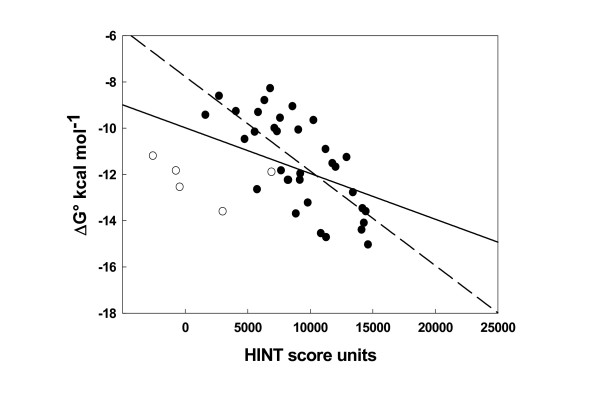
Correlation between the experimental binding free energies and the calculated HINT score values for the 39 analyzed protein-DNA complexes. Solid line is correlation for all 39 complexes; dashed line is correlation after five endonuclease I-CreI-DNA native and mutant complexes (1g9z, 1g9y, 1t9i, 1t9j, 1u0c; open symbols) are removed from dataset.